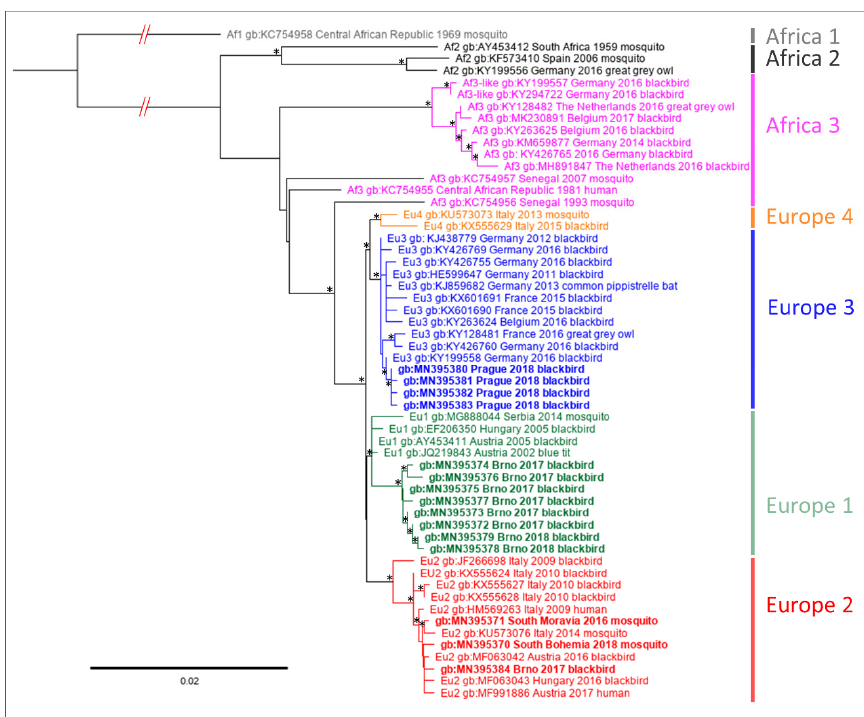
Figure 3. Phylogenetic maximum likelihood tree based on partial nucleotide sequence of prM protein and complete coding sequences of M and E proteins of Usutu virus (nucleotide positions 562–2475 according to complete genome sequence of Vienna strain, AY453411). Sequence Africa 1, AY453412, was used as the outgroup. The code of the sequences consists of GenBank accession number, place and year of origin. The sequences obtained in this study are indicated by bold; individual geographical lineages are color-coded. The tree was generated using the GTR + I substitution model and 1000 replicates bootstrap analysis. Nodes with bootstrap support of < 50% are indicated by asterisk. The lengths of tree branches correspond to the number of substitutions per